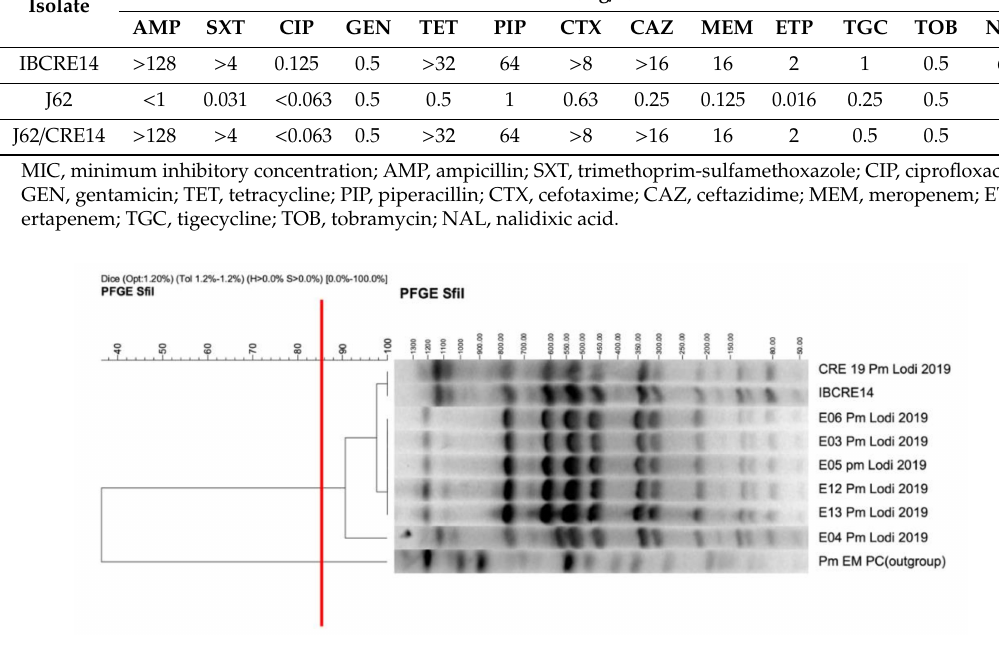
Figure 1. Dendrogram of seven out of the eight P. mirabilis strains along with the outgroup designated by Pm EM PC ( SfiI ; Dice coe ffi cient: optimization 1.2% and tolerance 1.2%–1.2%). The cut-o ff to determine di ff erent clonal groups was established at 85%, which is designated by the vertical red line. The scale bar at the left represents similarity coe ffi cient (%), while the one on the right represents fragments size